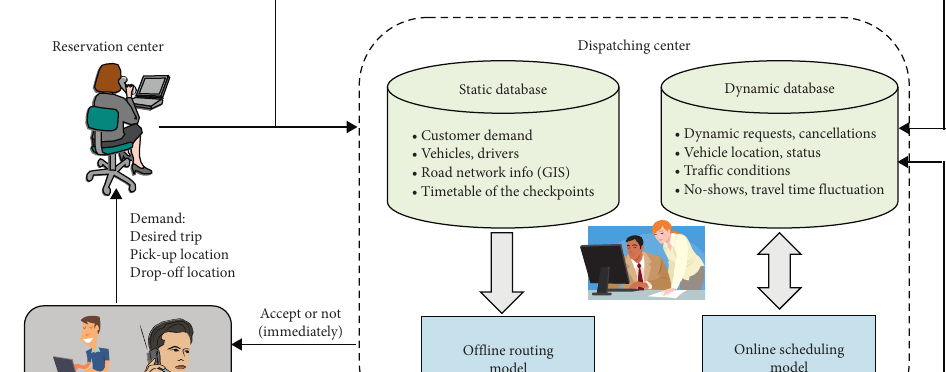
Figure 1: Flex-route transit service.